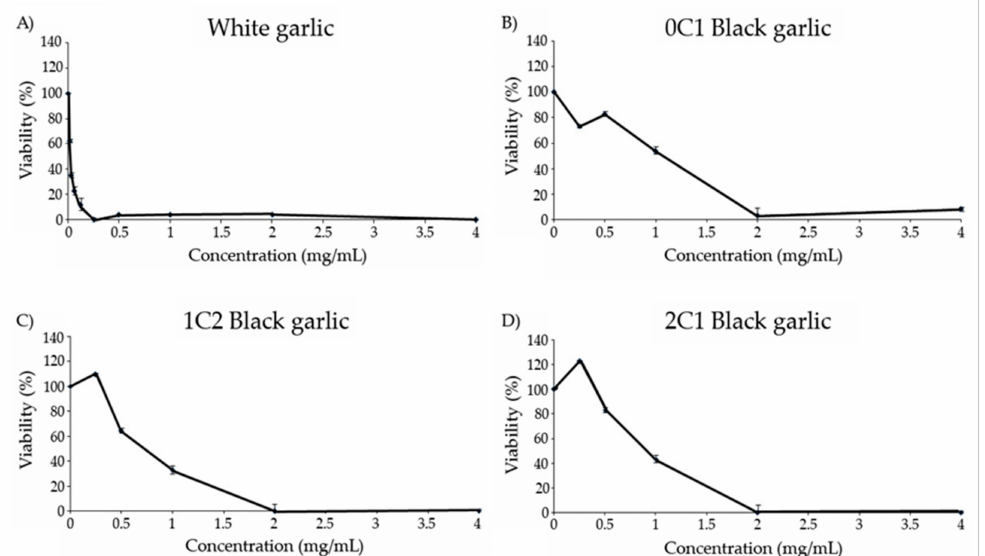
Figure 3. Viability of HL-60 cells treated with di ff erent concentrations of black and white garlic for 72 h. ( A ) White garlic, ( B ) 0C1: black garlic with 13 days aging, ( C ) 1C2: black garlic with 32 days aging, and ( D ) 2C1: black garlic with 45 days